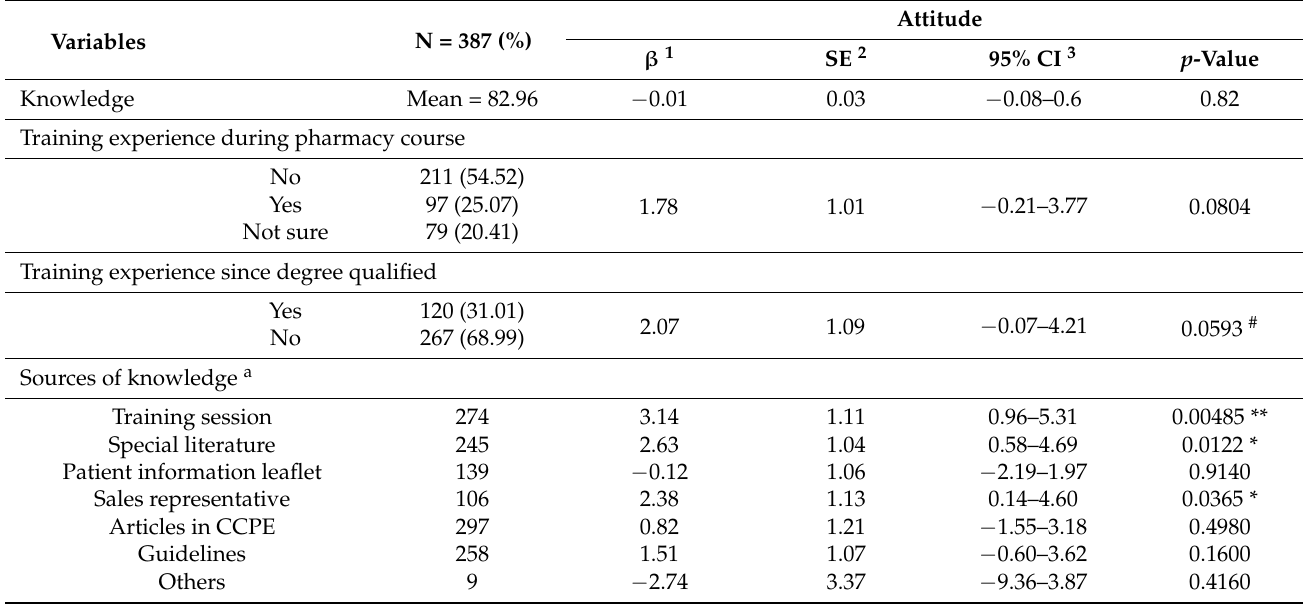
Table 5. Bivariate analysis of Attitude with antibiotic stewardship training